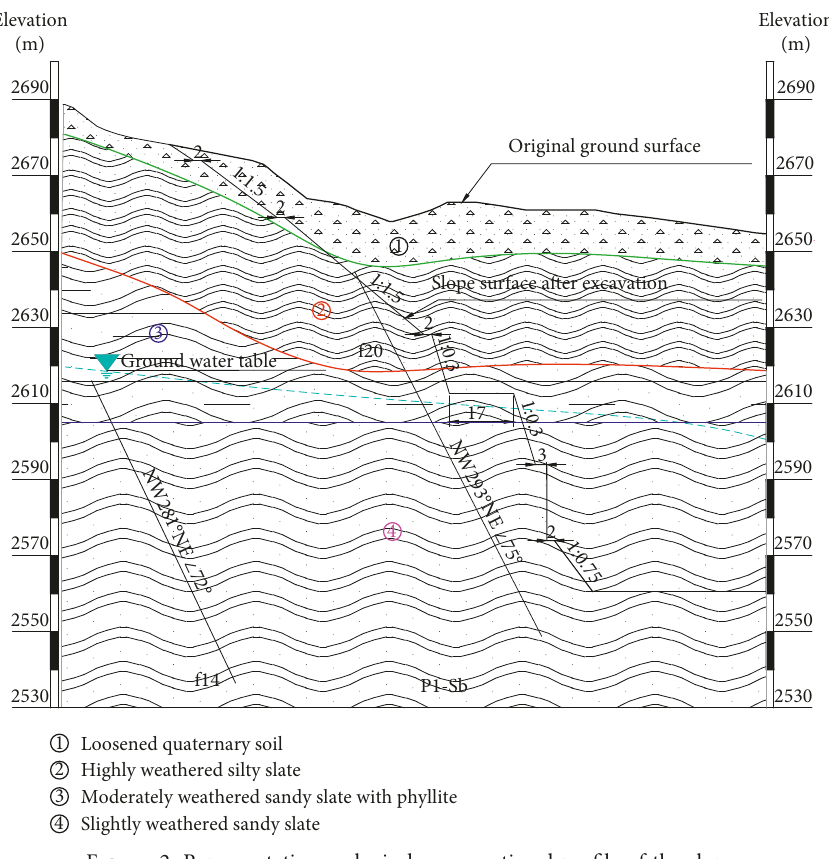
Figure 2: Representative geological cross-sectional profile of the slope. Table 1: Mechanical properties of the intact rock specimens.